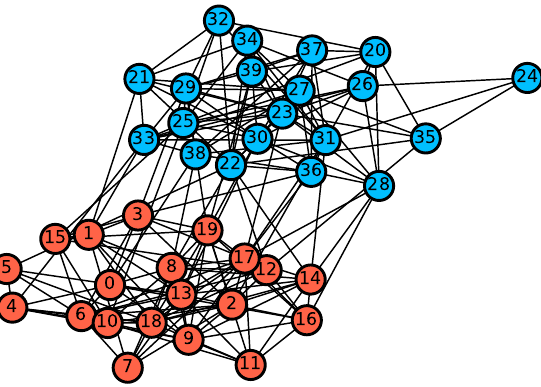
Figure 3. A synthetic network generated from the stochastic block model. Red and blue colors represent two underlying blocks, i.e., communities.